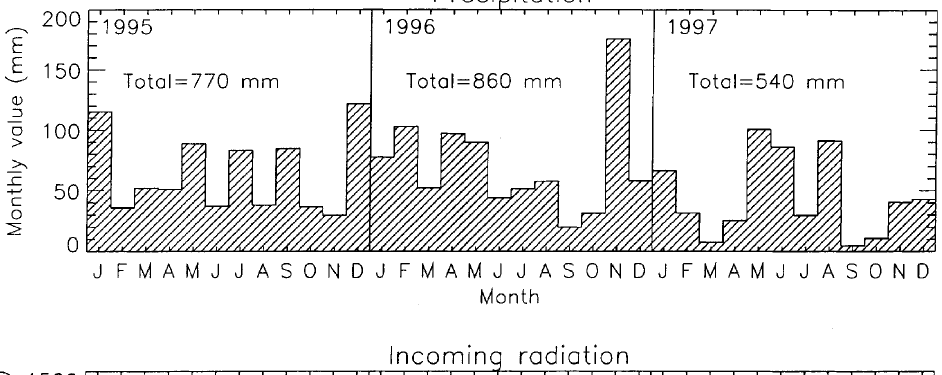
Fig. 2. The measured precip- itation and incoming radia- tion, Rg and Ra , over the MUREX fallow in 1995, 1996, and 1997. The plotted precipitation and incoming radiation are monthly sums of the 30-min